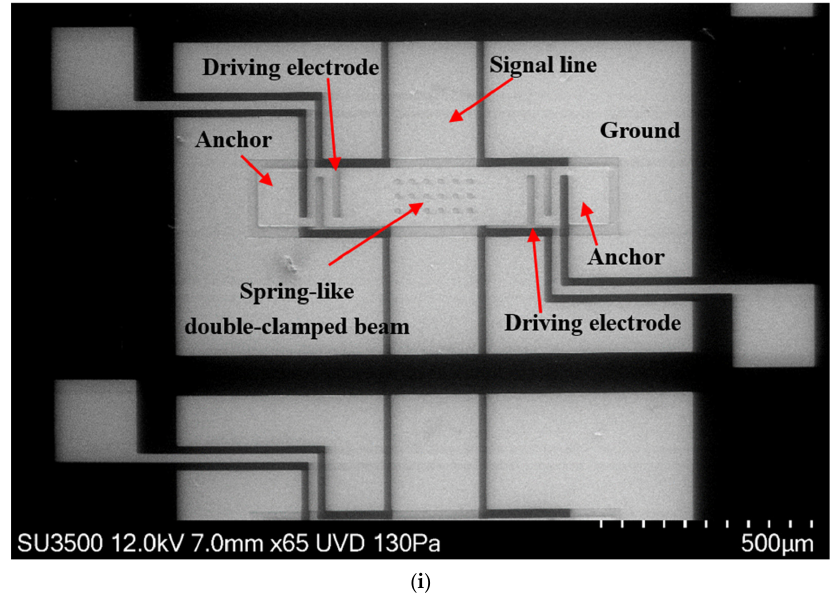
Figure 7. Process steps and SEM image of the double-clamped beam switch. ( a ) Sputtering Au seed layer. ( b ) Patterning and electroplating Au. ( c ) Etching redundant seed layer to form the transmission line and driving electrodes. ( d ) Patterning photoresist. ( e ) Sputtering a seed layer to form the anchors. ( f ) Patterning photoresist. ( g ) Electroplating Au to form the double-clamped beam. ( h ) Removing the redundant seed layer and photoresist. ( i ) The SEM image of the spring-like double-clamped beam